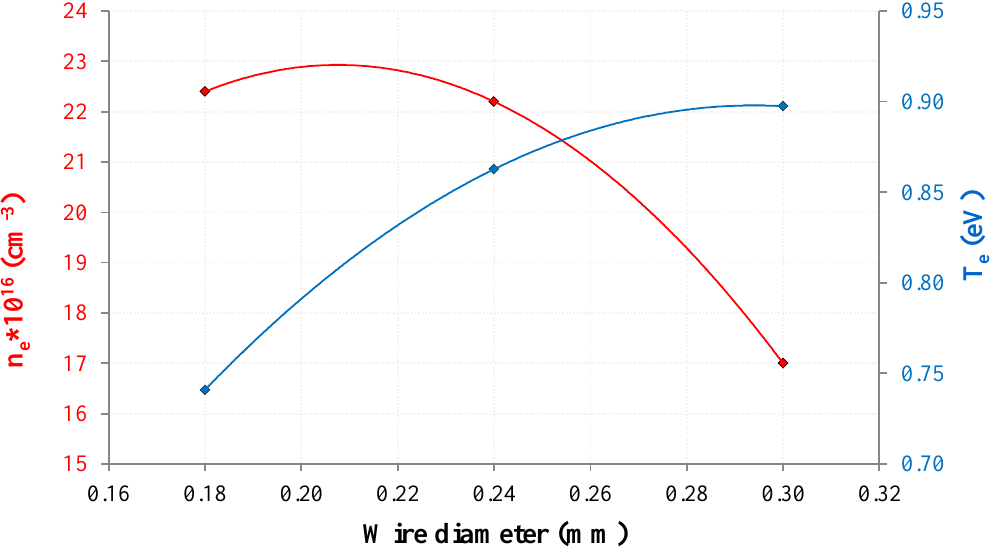
Fig. 5: Electron temperature T and electron density n for copper plasma produced by e e exploding wire for three different wire